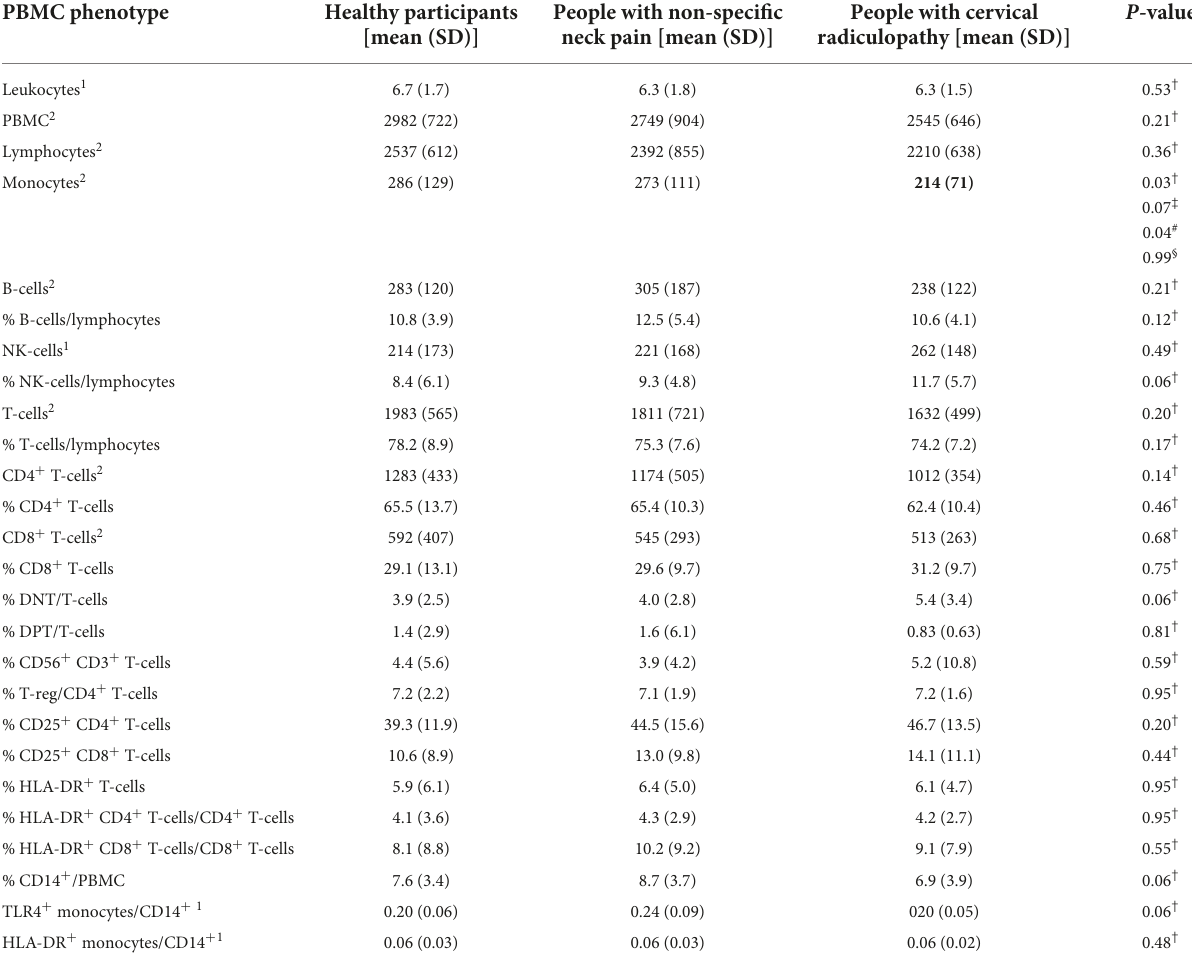
TABLE 4 Phenotypic analysis of peripheral white blood cells in people with non-specific neck pain, people with a cervical radiculopathy and healthy participants. PBMC phenotype Healthy participants